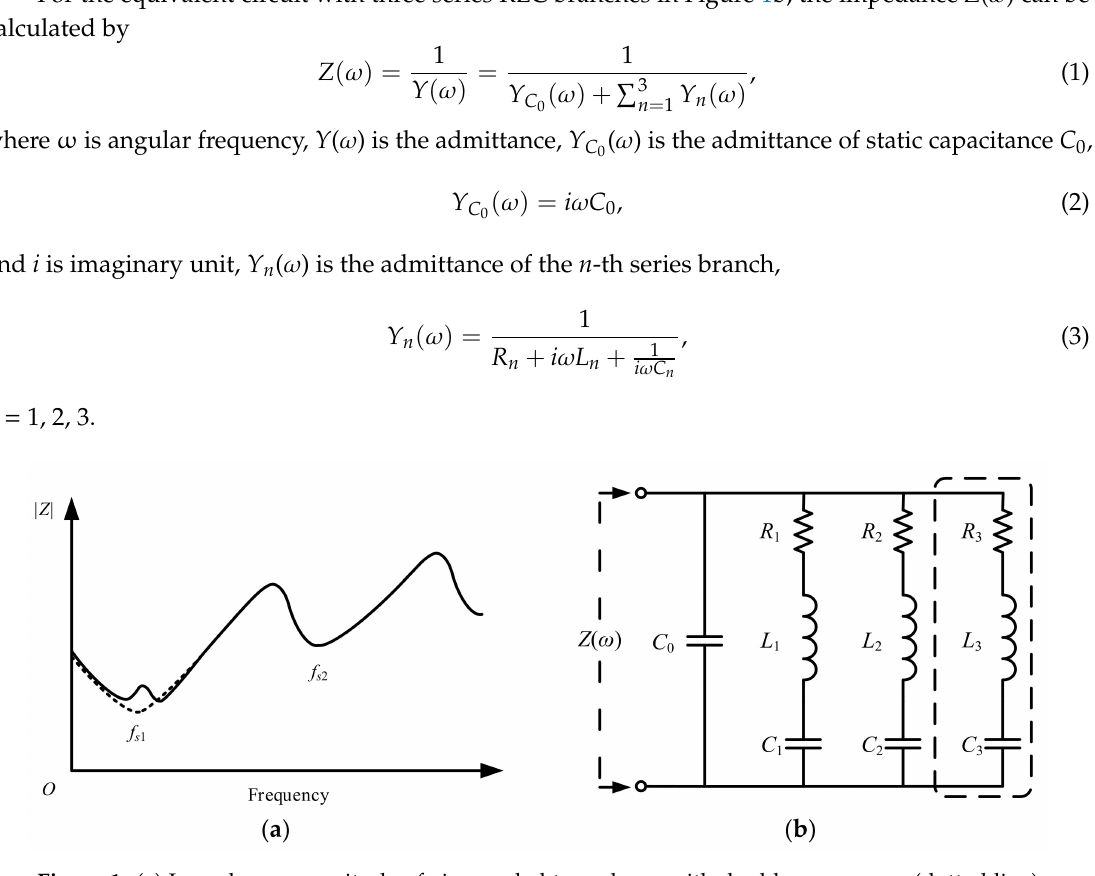
Figure 1. ( a ) Impedance magnitude of air-coupled transducer with double resonances (dotted line) and triple resonances including spurious resonance (solid line); ( b ) Butterworth–Van Dyke (BVD) equivalent circuit with multiple branches (additional branch in the dashed box is required to model the impedance with spurious